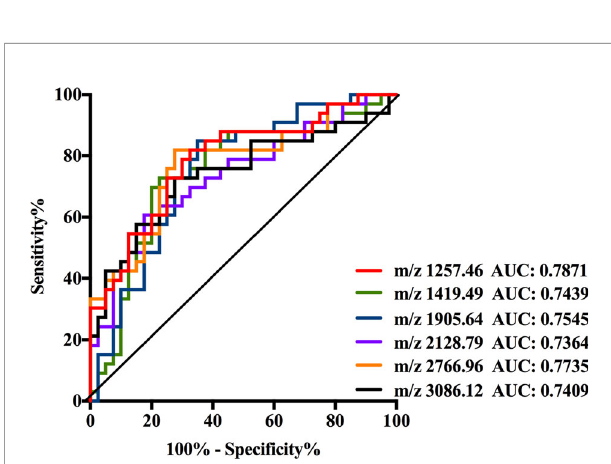
FIGURE 4 | Receiver operating characteristic (ROC) curve analyses for the six signi fi cantly changed individual N-glycan. The ROC was employed to evaluate the discrimination ef fi ciency of these N-glycans including: m/z1257.46, 1419.49, 1905.64, 2128.79, 2766.96, and 3086.12. Their AUC values were 0.7871, 0.7439, 0.7545, 0.7364, 0.7735, and 0.7409